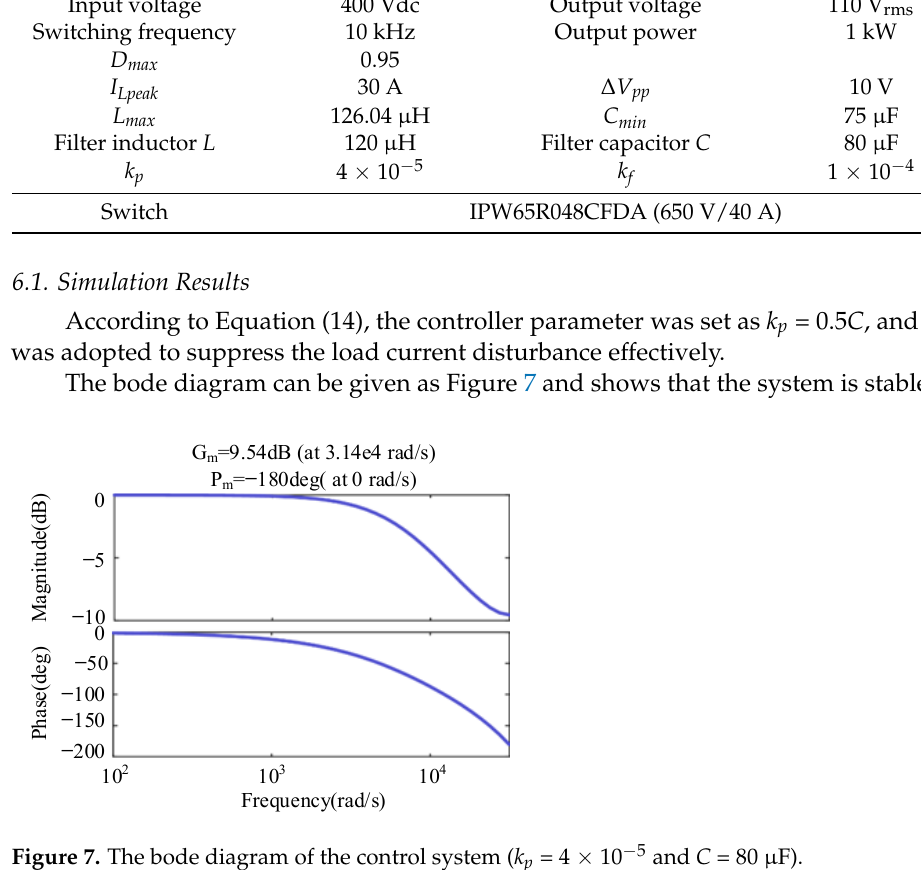
Figure 7. The bode diagram of the control system (kp = 4 × 10 − 5 and C = 80 μ F).